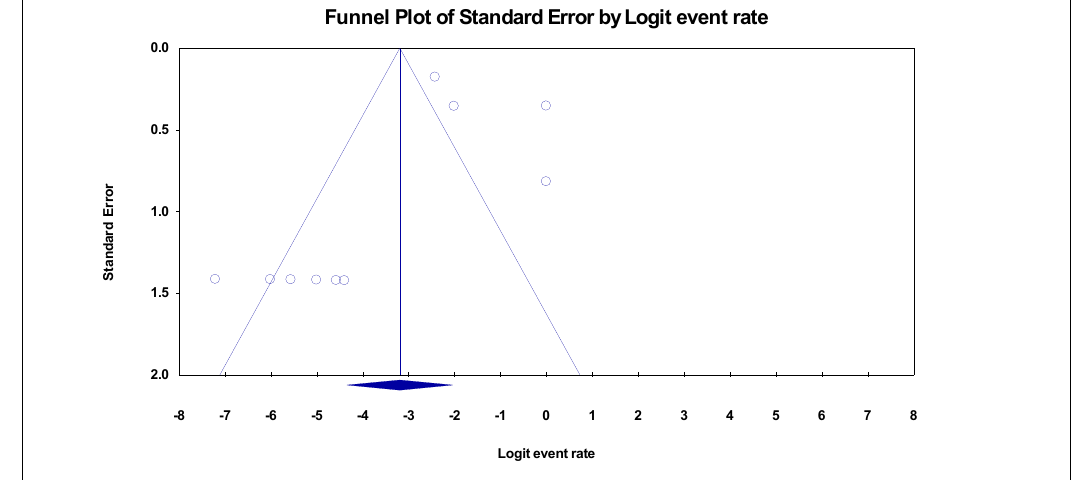
Figure 7. Funnel plot showing publication bias for SBP in HCV cirrhosis (Egger’s p = 0.28126).